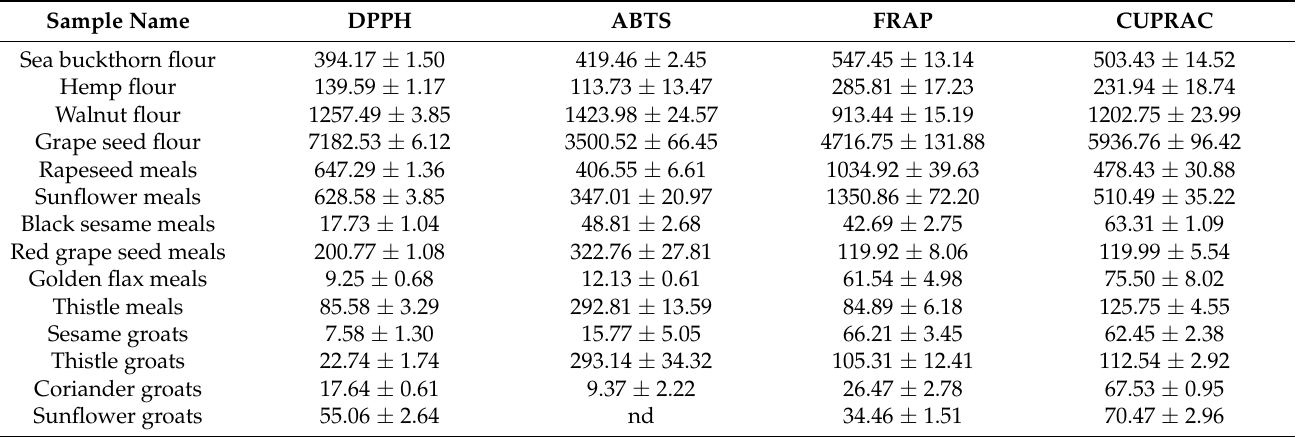
Table 2. Antioxidant activity of selected byproducts obtained in the vegetable oil